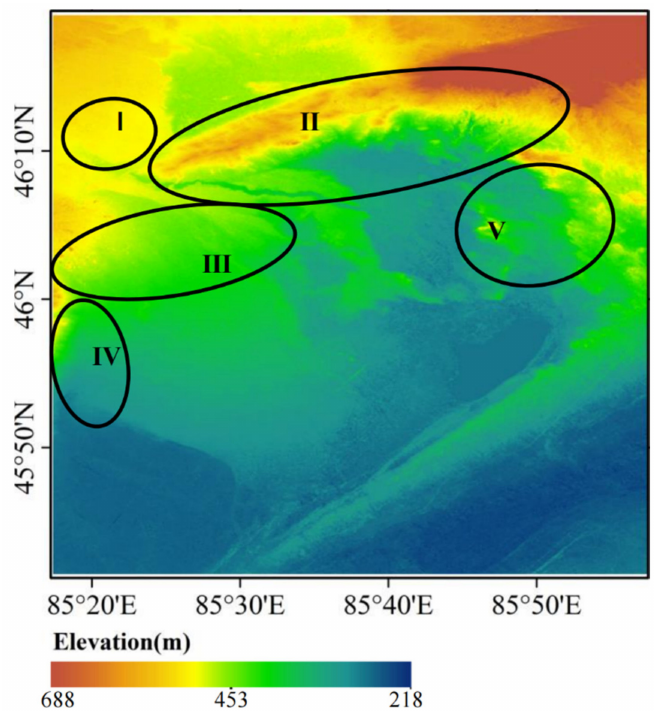
Figure 3. Elevation map of the study area overlain with the high LST anomaly areas.